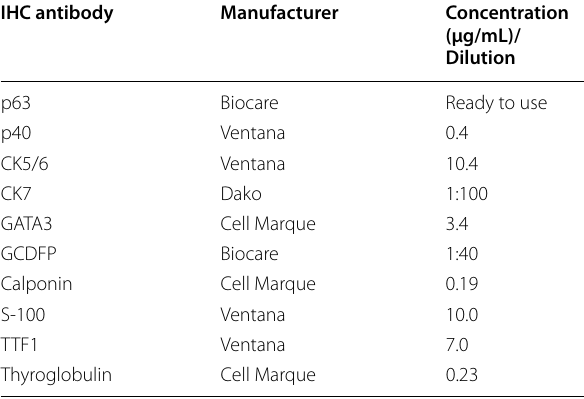
Table 2 IHC antibody